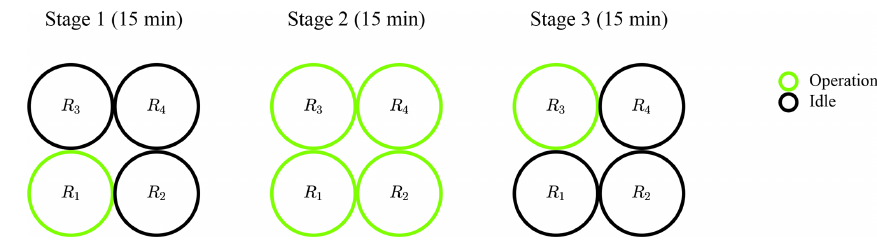
Figure 2. Test cycle of power curve measurements of the 4R-V29 wind turbine.